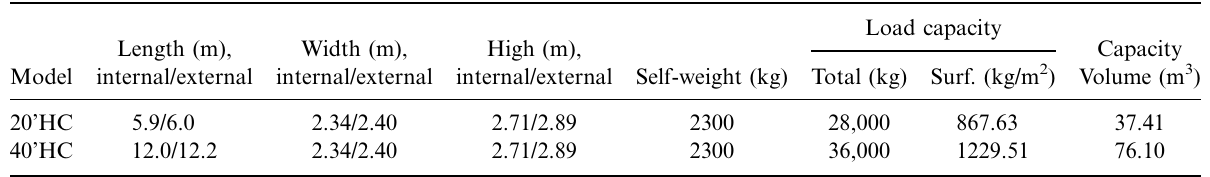
Table 1. Characteristics of containers 20’HC and 40’HC